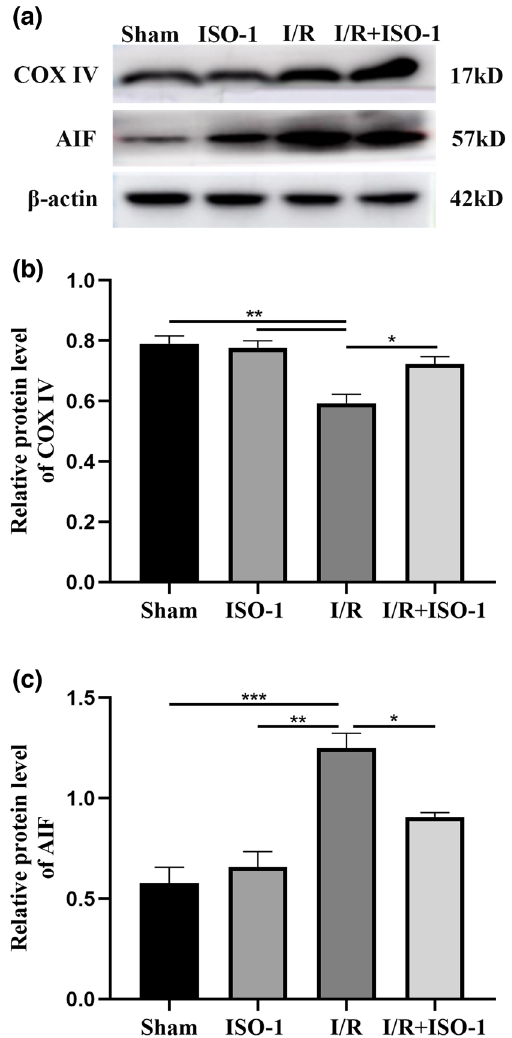
Figure 6. The expression levels of COX IV and AIF were detected by Western blotting. * P < 0.05, ** P < 0.01, *** P <